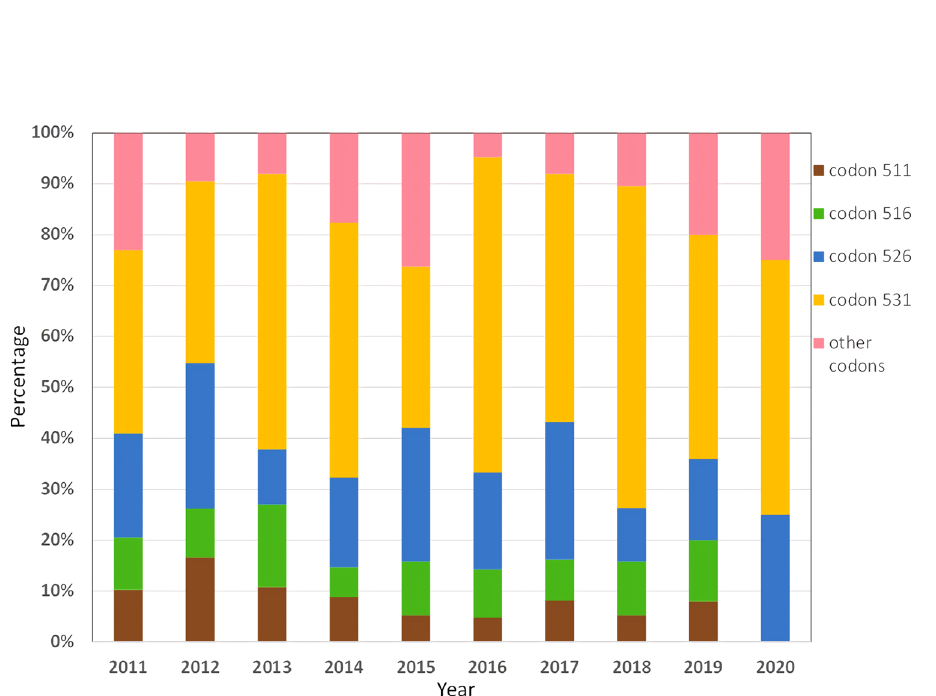
Figure 2. The percentage of major mutation sites in the rpoB gene from 2011 to